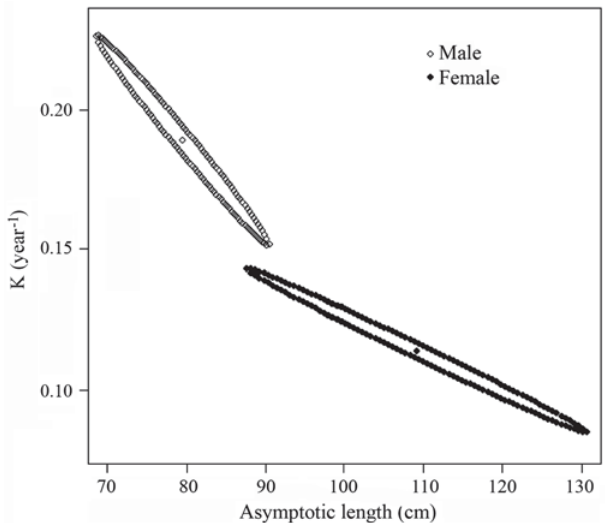
Fig. 8. Cross sections of approximate 95% confidence regions around least squares estimates ( L , K ) for growth parameters ∞ of males and females of Scomberomorus brasiliensis collected off northeastern Brazil.